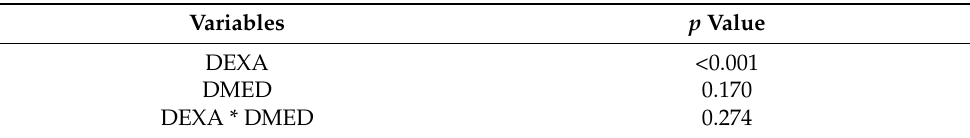
Table A2. The result of mixed-effect model for analgesic duration. DEXA: dexamethasone, DMED: Dexmedetomidine. * Asterisk indicates interaction between the two factors (DEXA and DMED). DEXA and DMED were treated as a factor in this